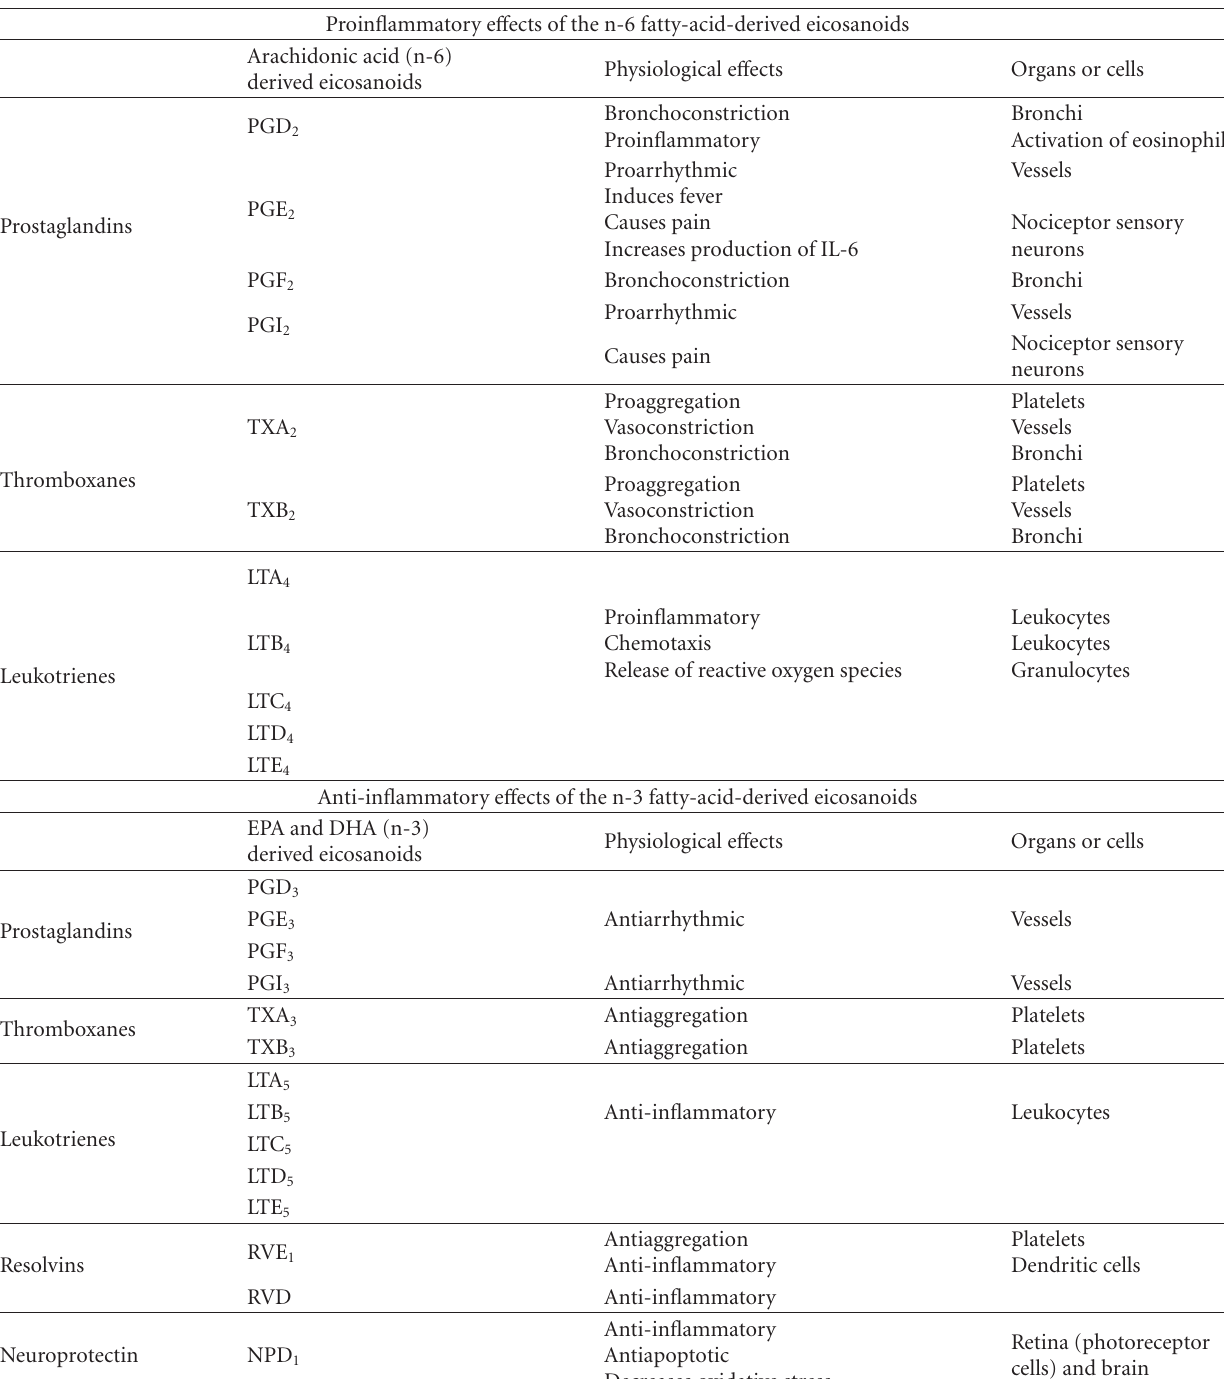
Table 2: Proinflammatory e ff ects of n-6 fatty-acid-derived eicosanoids and anti-inflammatory e ff ects of the n-3 fatty-acid-derived